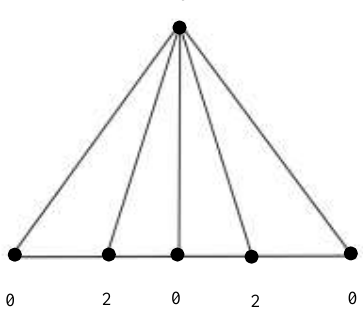
Figure 4: Modern Roman domination of fan graph.